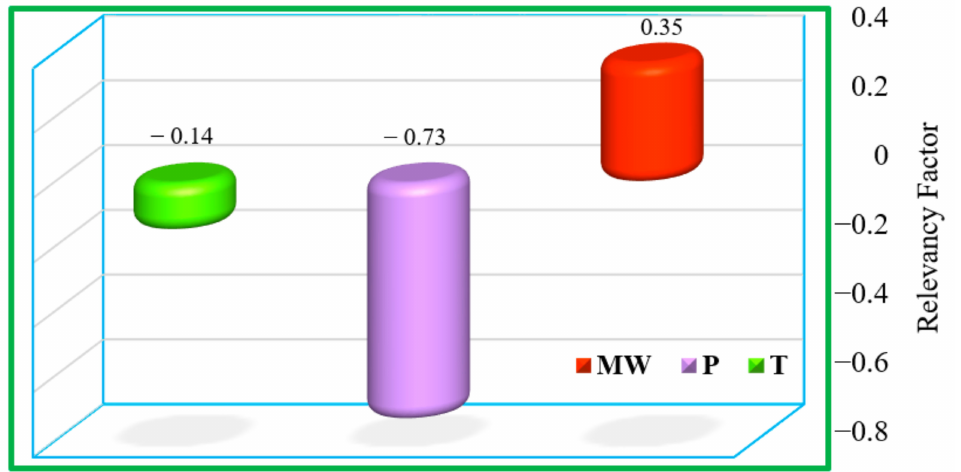
Figure 8. Impact of input parameters on the magnitudes of IFT